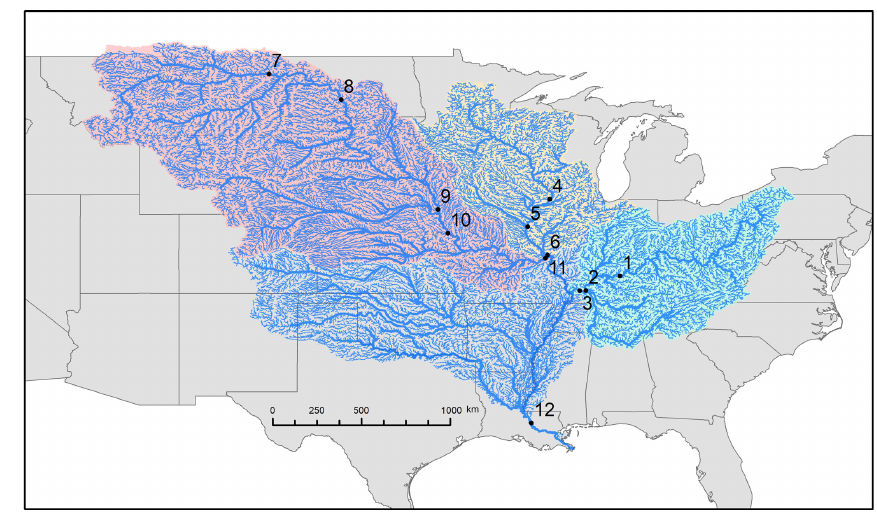
Figure 1. Study region with the location of selected USGS streamflow gauges. Table 1. USGS gauge information and streamflow statistics: mean annual non-winter monthly discharge ( Q m ), mean annual